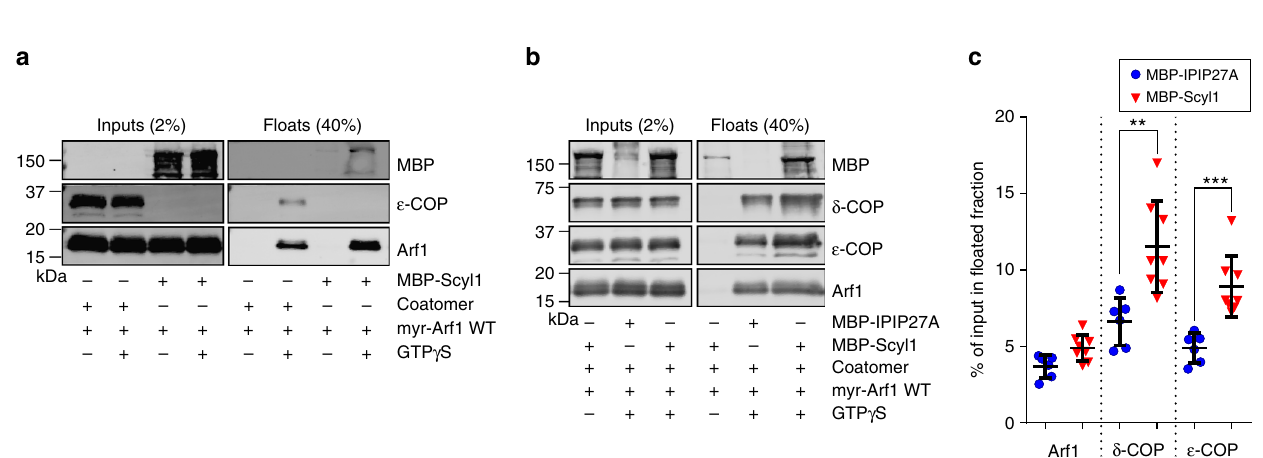
Fig. 6 Scyl1-dependent recruitment of COPI to arti fi cial membranes. a Liposome recruitment assay with puri fi ed MBP-Scyl1, myr-Arf1 and recombinant coatomer. Inputs (2%) and membrane-bound fractions (40%) were subjected to SDS-PAGE and blotted for MBP, ε -COP and Arf1. b Liposome recruitment assay with puri fi ed MBP-IPIP27A (as negative control), MBP-Scyl1 and myr-Arf1 and recombinant coatomer. Inputs (2%) and membrane-bound fractions (40%) were subjected to SDS-PAGE and blotted for MBP, δ -COP, ε -COP and Arf1. c Quanti fi cation of recruitment of Arf1 and coatomer ( δ -COP, ε -COP) to liposomes in the presence of MBP-IPIP27A and MBP-Scyl1. Error bars represent mean ± SD, n = 6 independent experiments, ** p < 0.01, *** p < 0.001, unpaired t